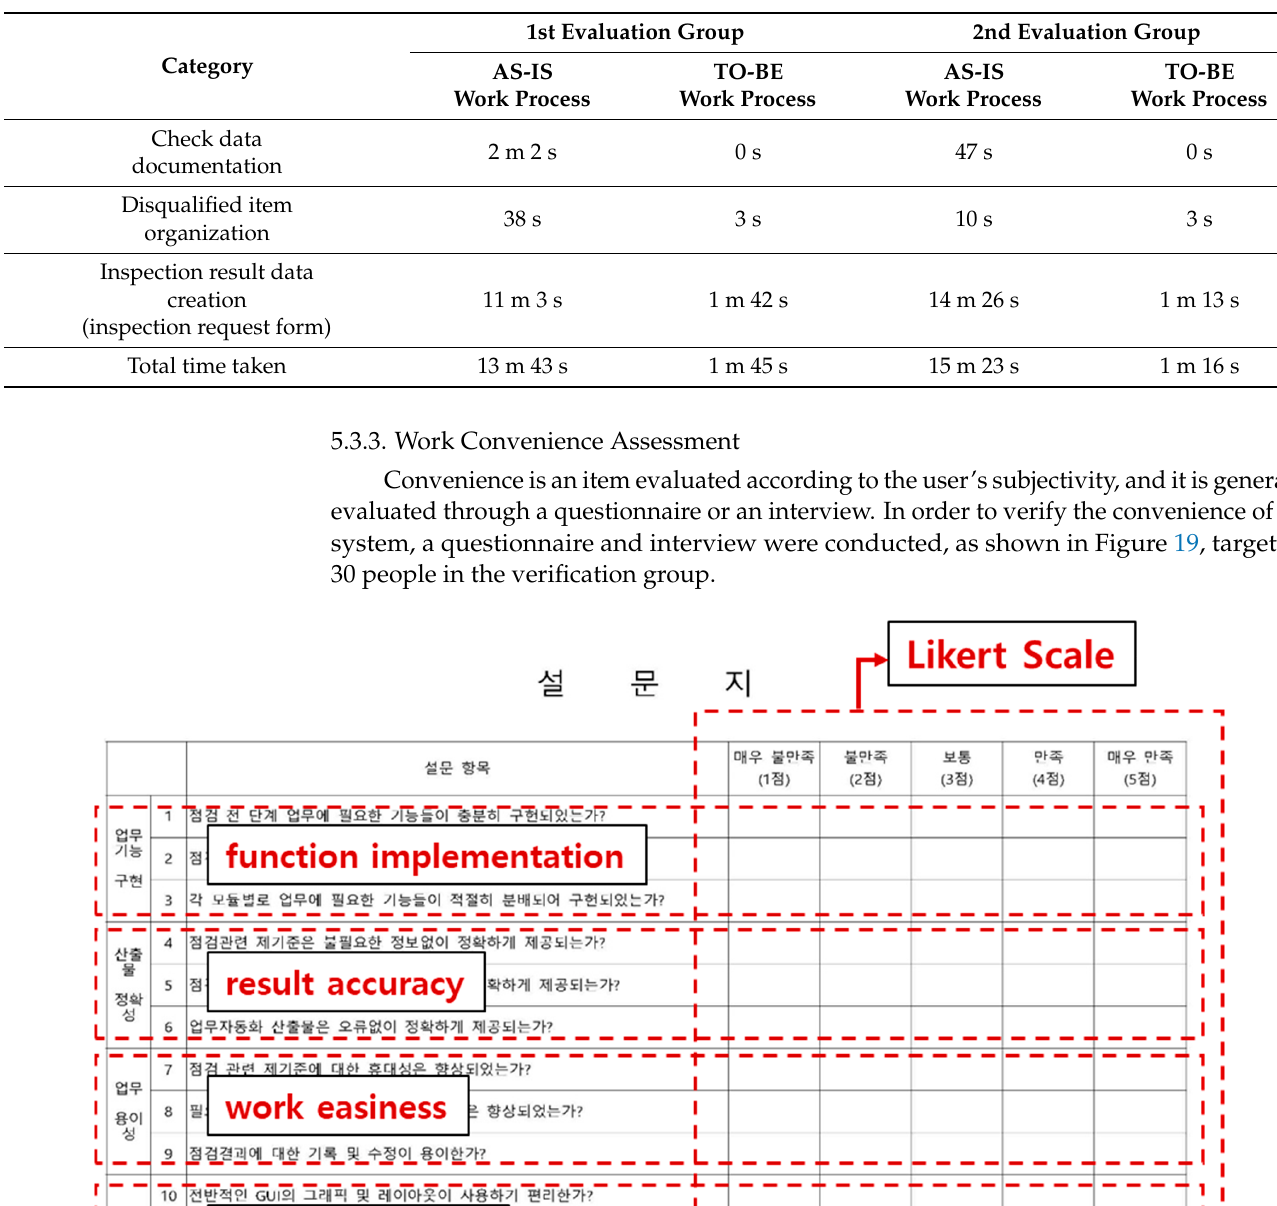
Table 9. Result of the amount of time taken for each work process in the post-inspection work.